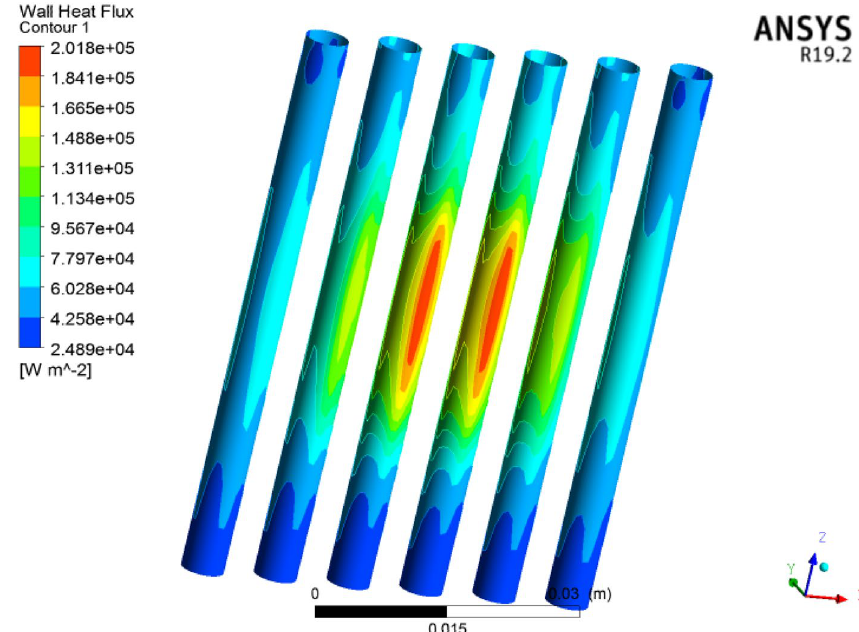
Figure 23. Wall heat flux contour in six circular microchannels.